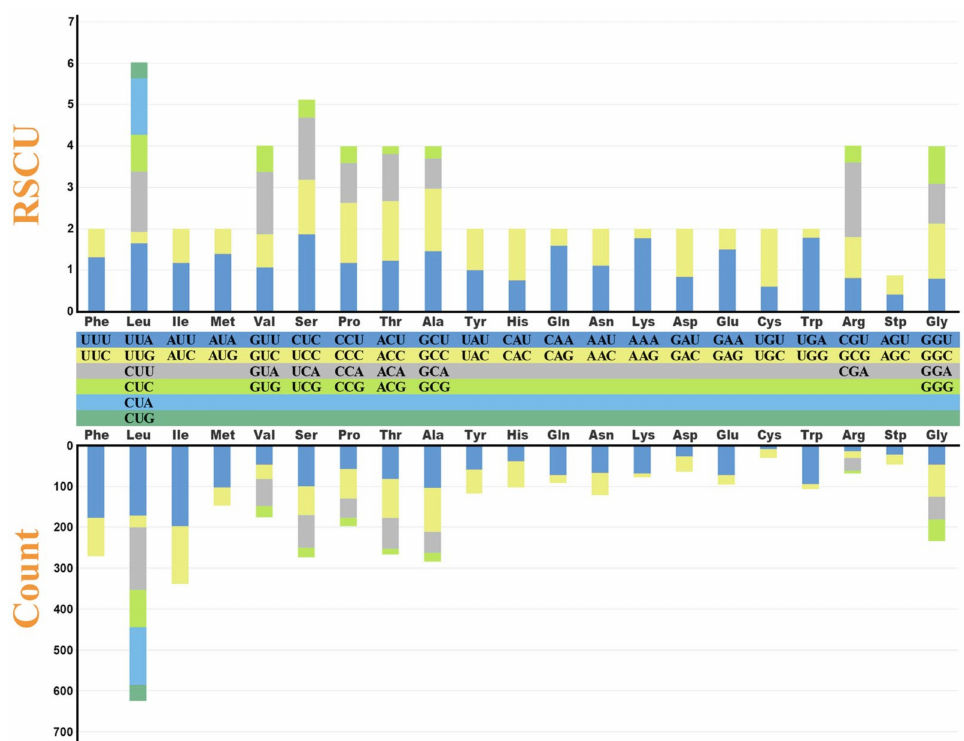
Figure 2. Relative synonymous codon usage (RSCU) in the mitogenome of Oreolalax omeimontis . The different colors in the column chart represent the codon families corresponding to the amino acids below and use consistent colors to represent the same codon families. The stop codon is